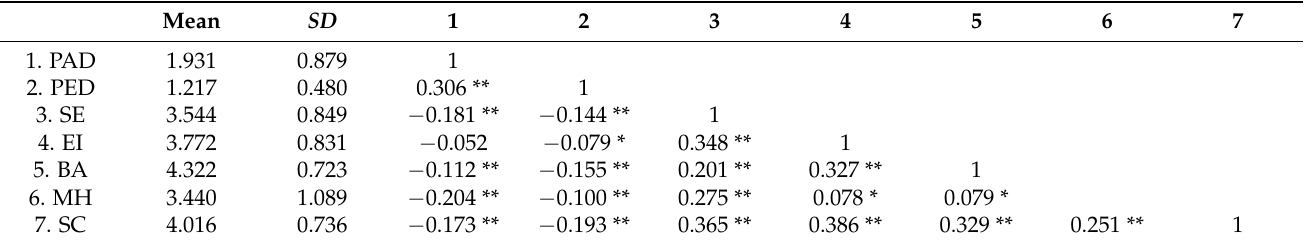
Table 2. Descriptive statistics and bivariate correlations for key